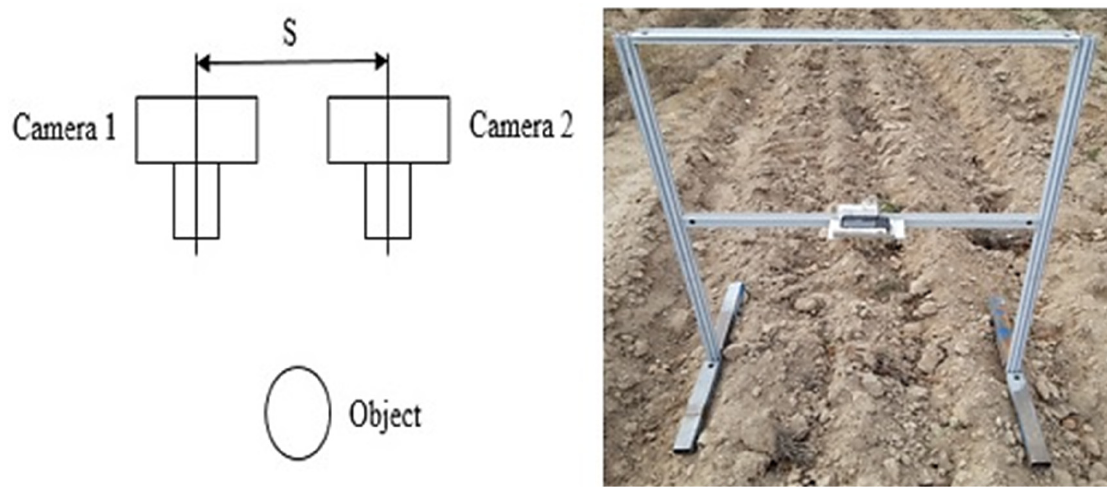
Figure 1. Schematic of the stereo imaging with its setup.